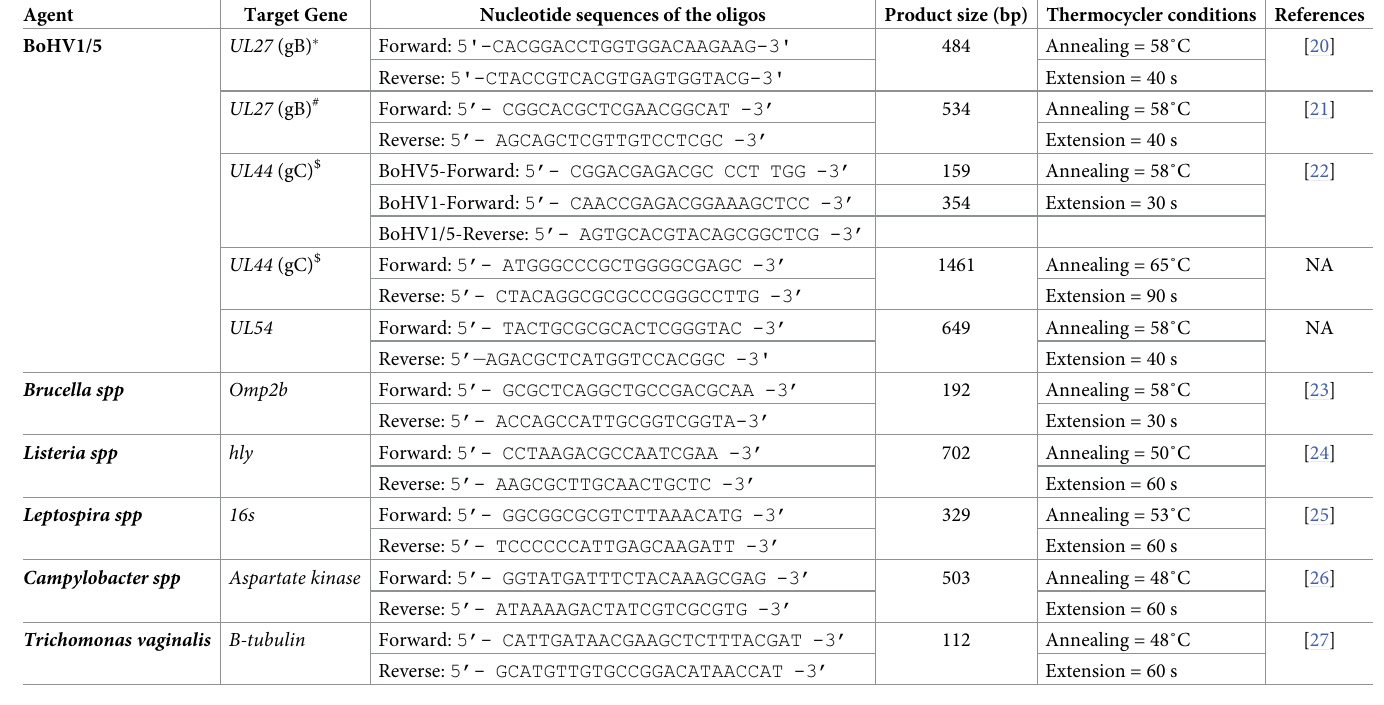
Table 1. Oligos to amplify various agents potentially involved in